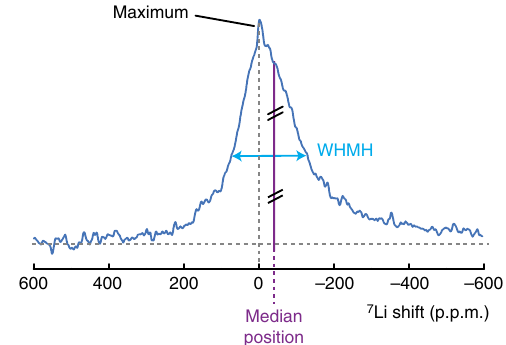
Figure 4 | Metrics used to follow the spectral evolution. The median position is defined as the position for which the area on the left side is the same as on the right side. The width at half median height (WHMH) gives a good estimate of the width of the peak, even if it